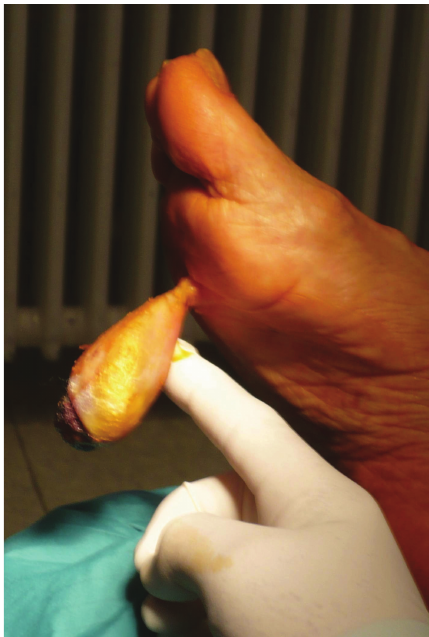
Figure 2: Rare pedunculated tumor of the plantar